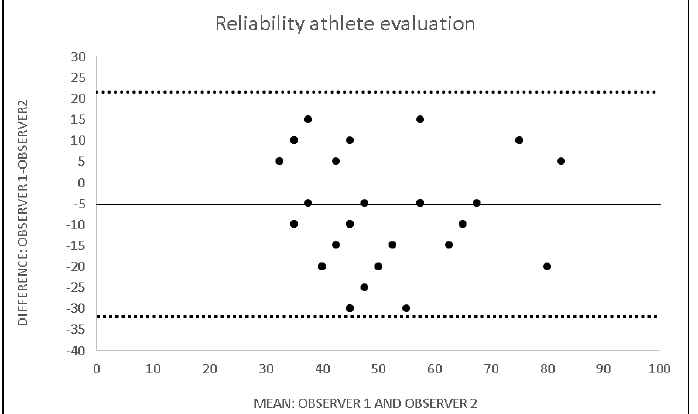
Figure 2. Inter-observer differences.